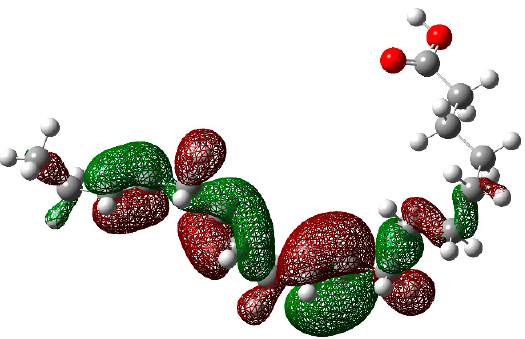
Figure 8. Optimized structure of the α -linoleic acid in the aqueous phase.